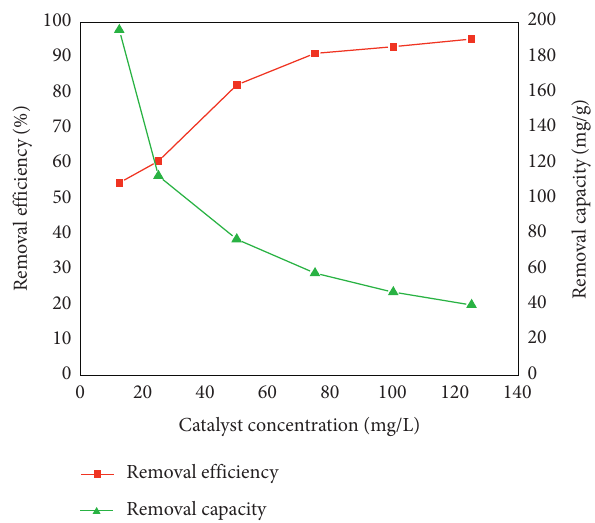
Figure 4: Effect of catalyst concentration (pH 6.3, 1 UV-A light bulb, 90min of reaction